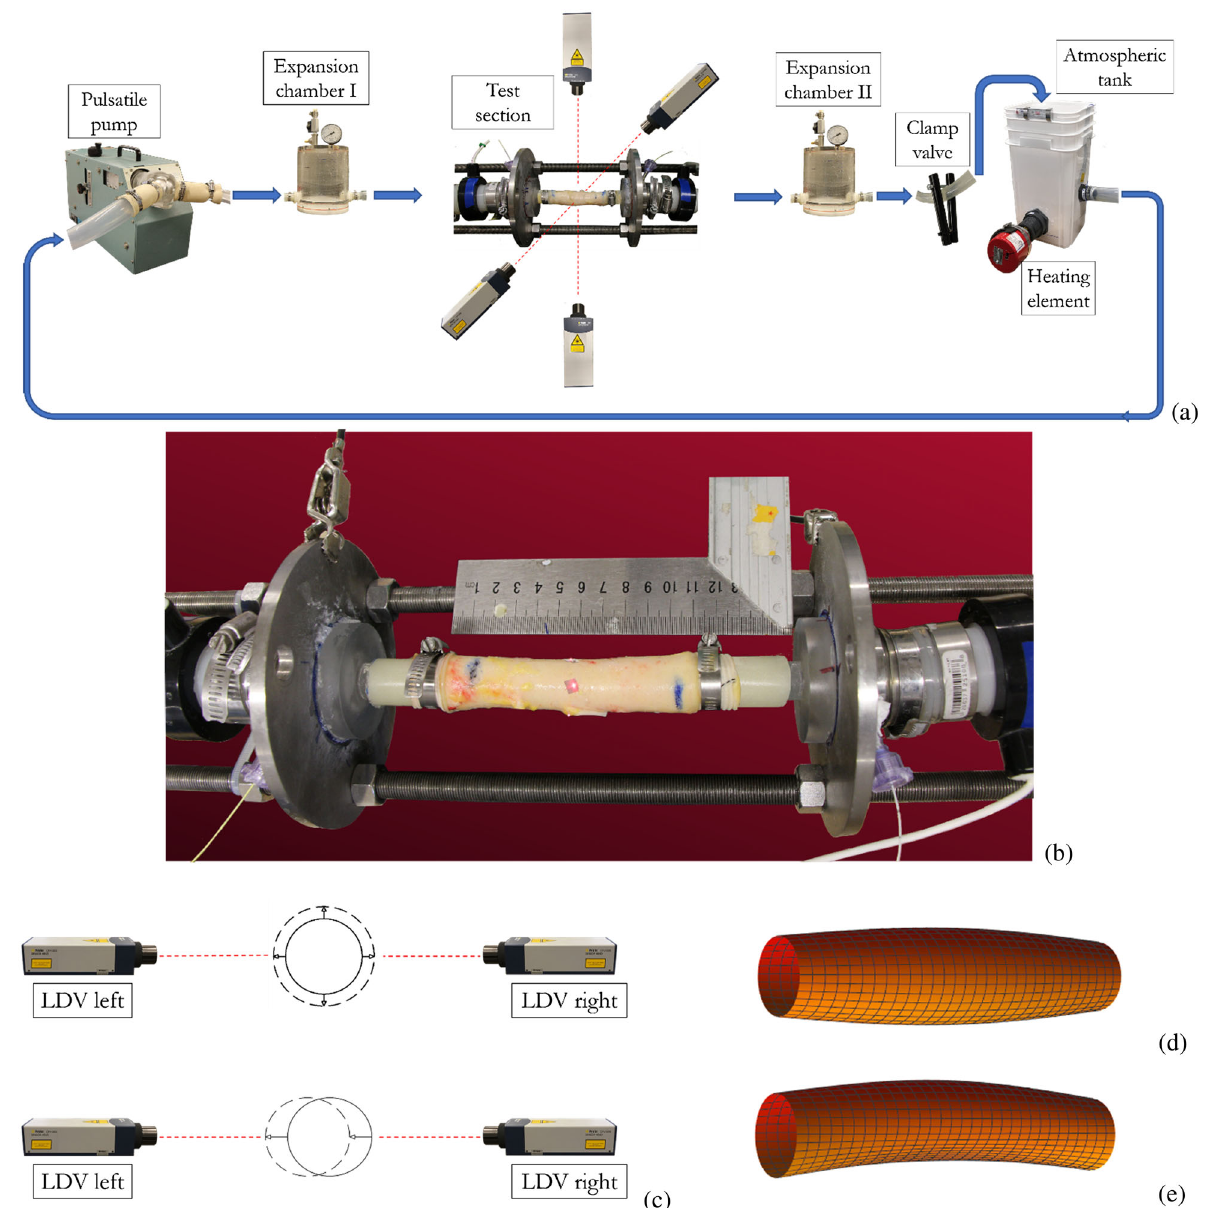
FIG. 1. Experimental setup with dynamic measurement schematic: (a) scheme of the MCL: Harvard Apparatus volumetric pump, expansion chamber, test section, second expansion chamber, pinch valve, atmospheric tank with thermal heater and temperature control; (b) test section of the MCL with the assembled aorta from donor VII, two flowmeters and two catheter pressure gauges (the thin wires coming out from them are clearly visible); the reflecting tapes with laser spots are visible; (c) top: cyclic change of the aortic diameter, shown in a cross-section, measured by two aligned laser Doppler vibrometers (LDV), bottom: bending oscillation of the aorta, shown in a cross-section, measured by two aligned LDV; (d) axisymmetric diameter change of the aortic segment; (e) bending oscillation of the aortic